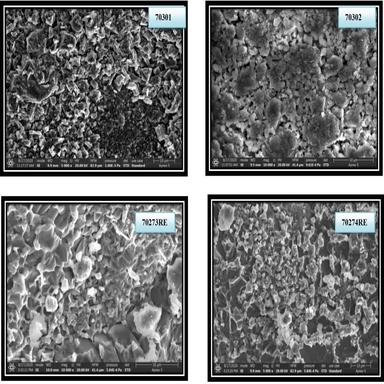
Results of SEM micrograph of all four NEG material.